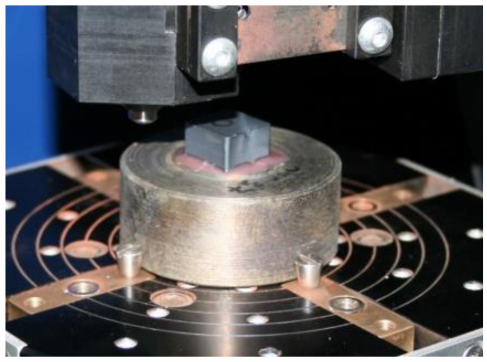
Figure 5. The system for studying the friction coefficient of ceramic